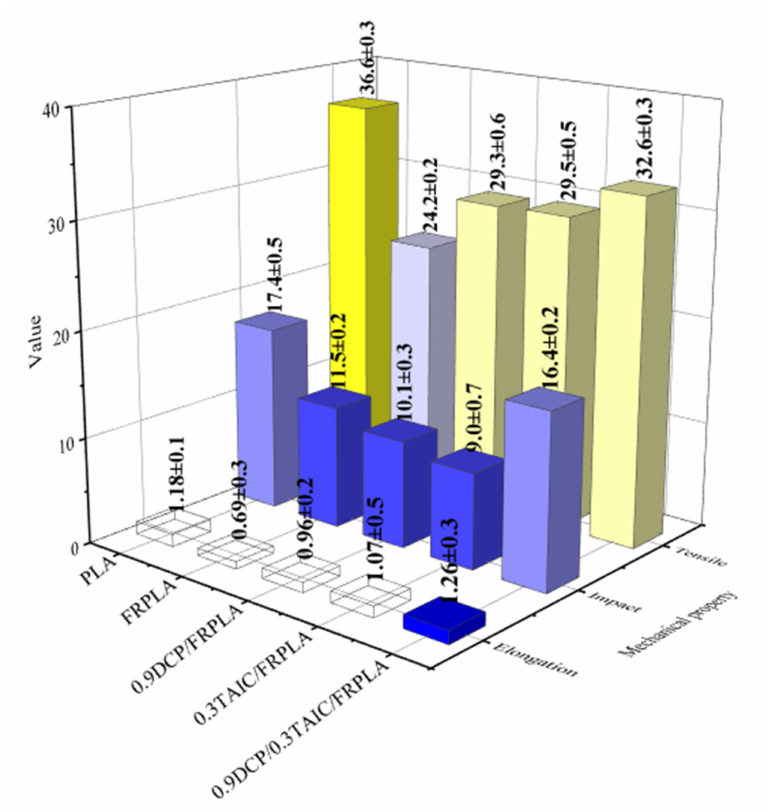
Figure 4. The mechanical properties of pure PLA and PLA